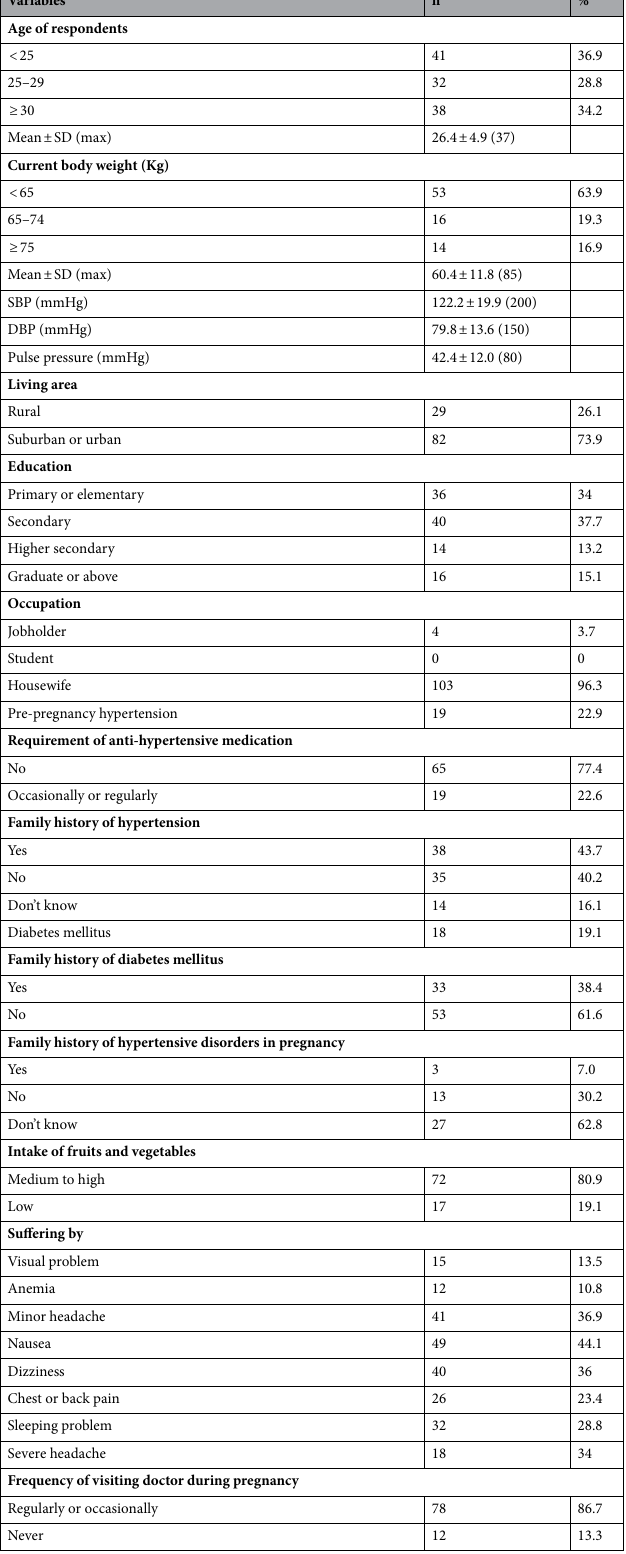
Table 1. Sociodemographic characteristics of the participants. Information about pre-pregnancy hypertension, diabetes mellitus, and amount of fruits and vegetable intake was collected from the participants. Family: it comprises of a group of kin related to each other by blood connection or by marital